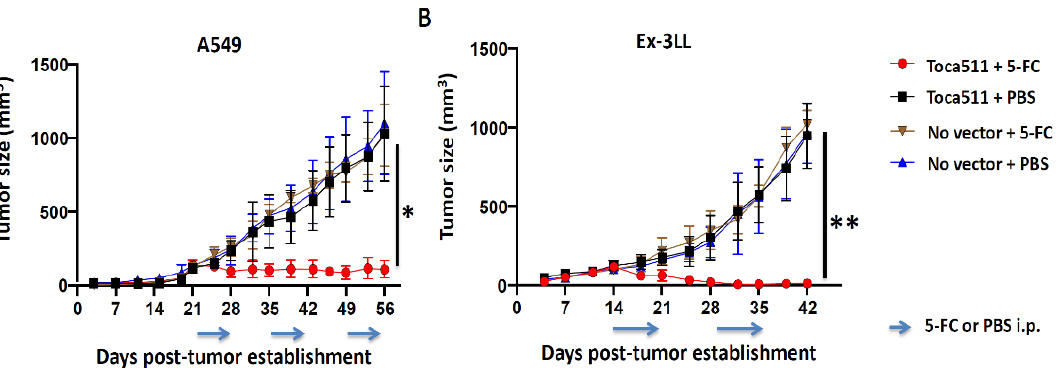
Figure 4. Therapeutic efficacy of Toca 511 and 5-FC therapy in subcutaneous tumor models of A549 human lung cancer and Ex-3LL murine lung cancer. Dorsal flank tumors were established and Toca 511 infection was initiated starting from an initial transduction level of 1% ( n = 5/group). Uninfected tumors served as negative controls (‘No vector’). Data are shown as the mean ± SD. ( A ) Tumor growth curves for subcutaneous A549 human lung cancer xenograft models. Prodrug (5-FC) or saline vehicle (PBS) treatments were administered daily (500 mg/kg i.p.) for 7 consecutive days every other week, starting from day 21 post-tumor establishment (indicated by arrows); * p = 0.0051. ( B ) Tumor growth curves for subcutaneous Ex-3LL murine lung cancer tumor models in immunocompetent syngeneic mice. As above, prodrug (5-FC) or saline vehicle (PBS) treatments were administered daily (500 mg/kg i.p.) for 7 consecutive days every other week, starting from day 14 post-tumor establishment (arrows); ** p = 0.0018.